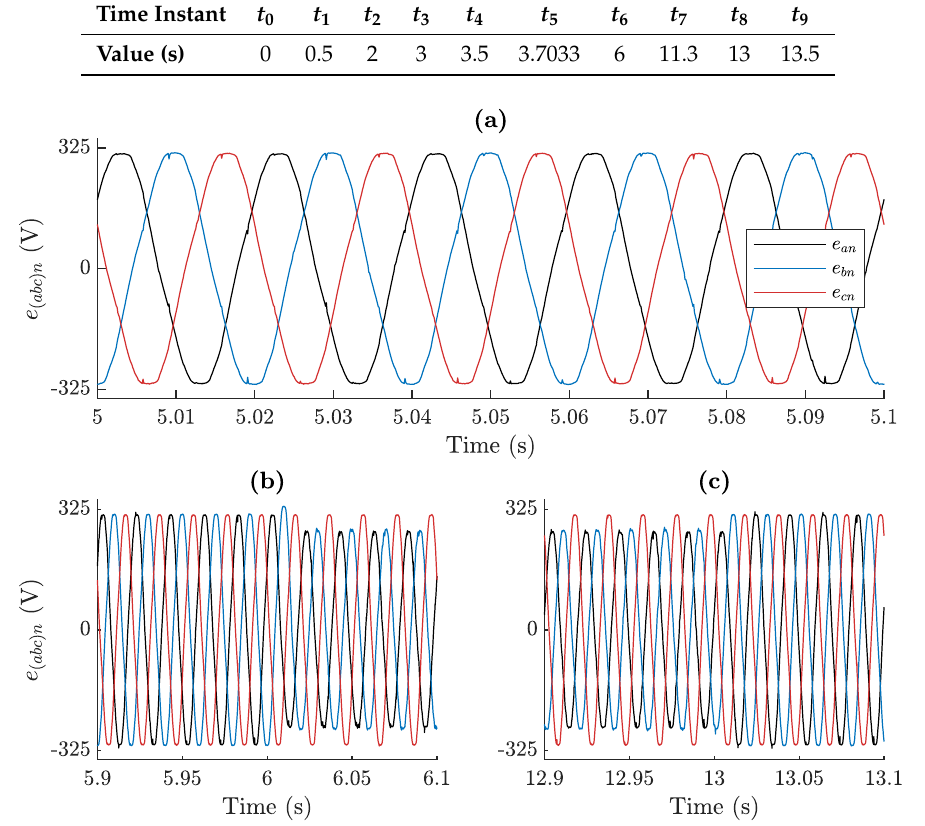
Figure 7. Grid voltage profile: ( a ) Harmonic distortion in the absence of imbalance; ( b ) zoom at the start of the imbalance; and ( c ) zoom at the end of the